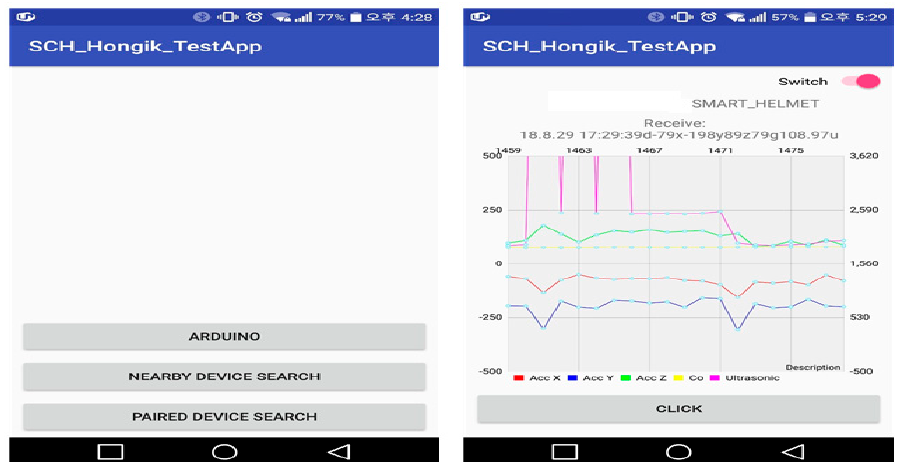
Figure 7. Screenshots of the personal smartphone app for transmitting data.